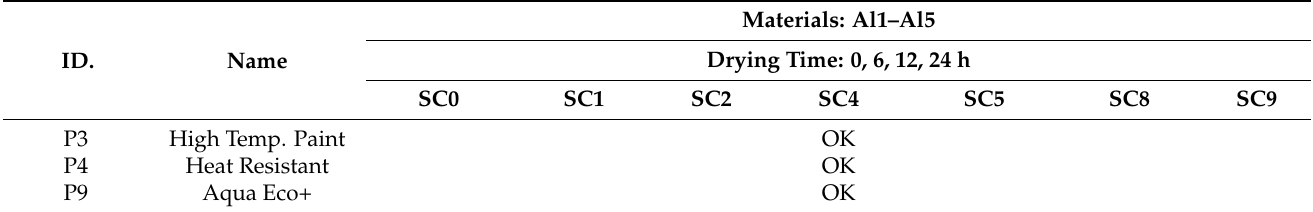
Table 9. Results of the visual inspection of the Erichsen test.